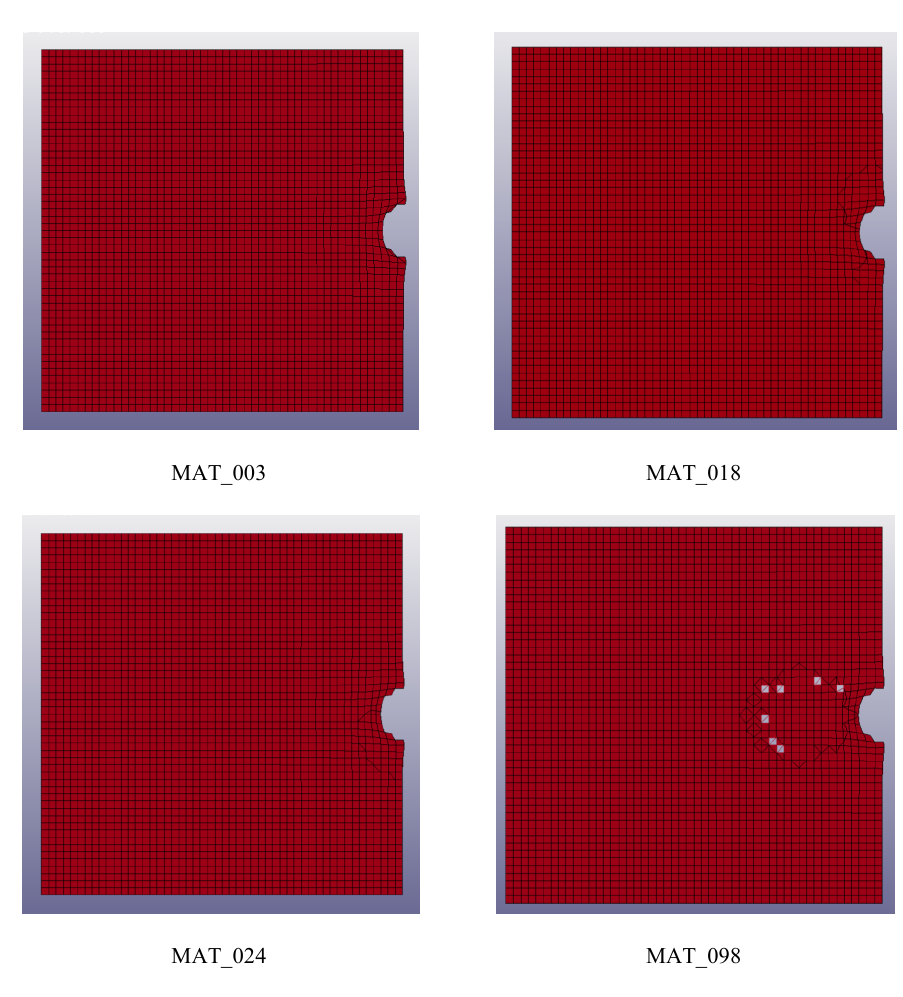
Fig. 2. Depth of penetration.